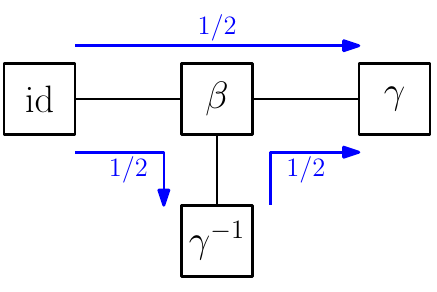
Figure 25 . A flow solving the one-tensor network with unit